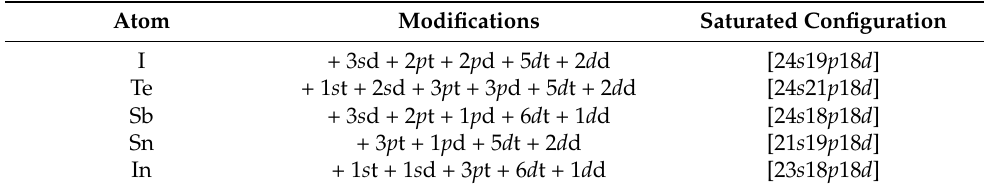
Table 1. Configurations of saturated heavy basis sets 1 .